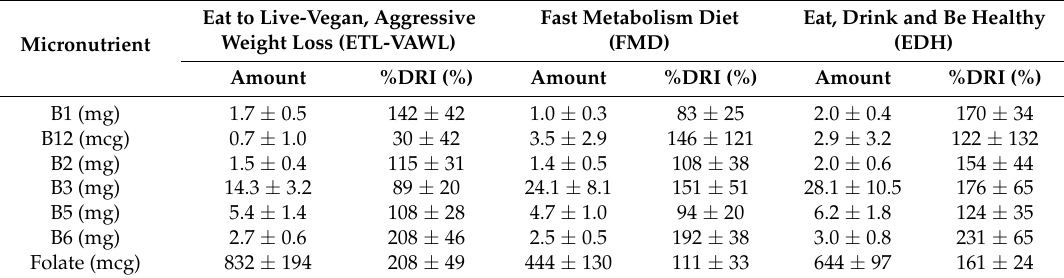
Table 3. Micronutrient content of three weight-loss diet plans compared to Dietary Reference Intake (DRI) values for U.S male adults